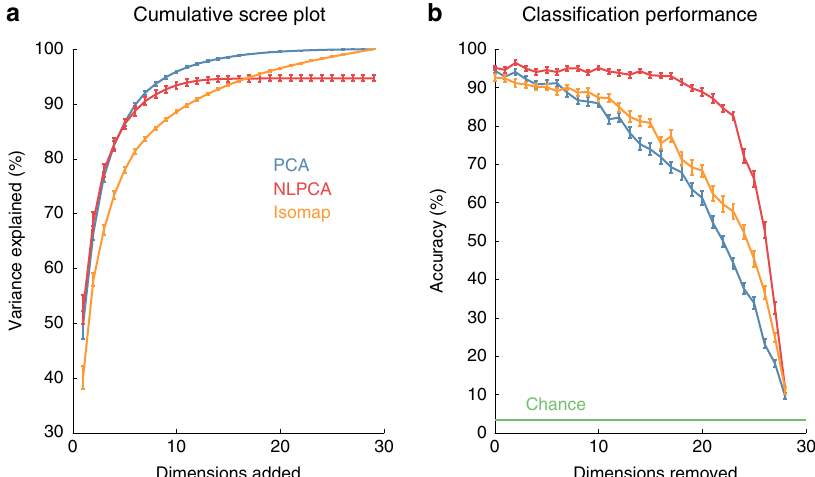
Fig. 6 Scree plot and classi fi cation performance using different dimension reduction techniques. a Cumulative variance explained by each dimension of PCA, NLPCA, and Isomap, averaged across the down-sampled data of eight subjects. b Mean grasp classi fi cation performance after progressively removing dimensions from high variance to low, for each of the three dimensionality reduction techniques. Results are averaged across eight subjects with fi ve repetitions each. Error bars indicate ±